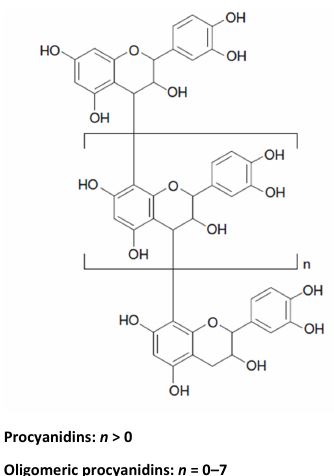
Figure 8. Chemical structure of procyanidins